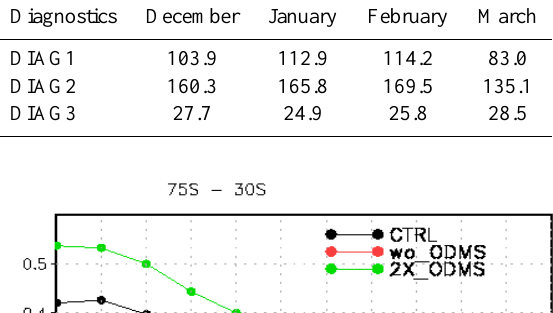
Table 2. Percentage mean change in DIAG1, DIAG2, DIAG3 for